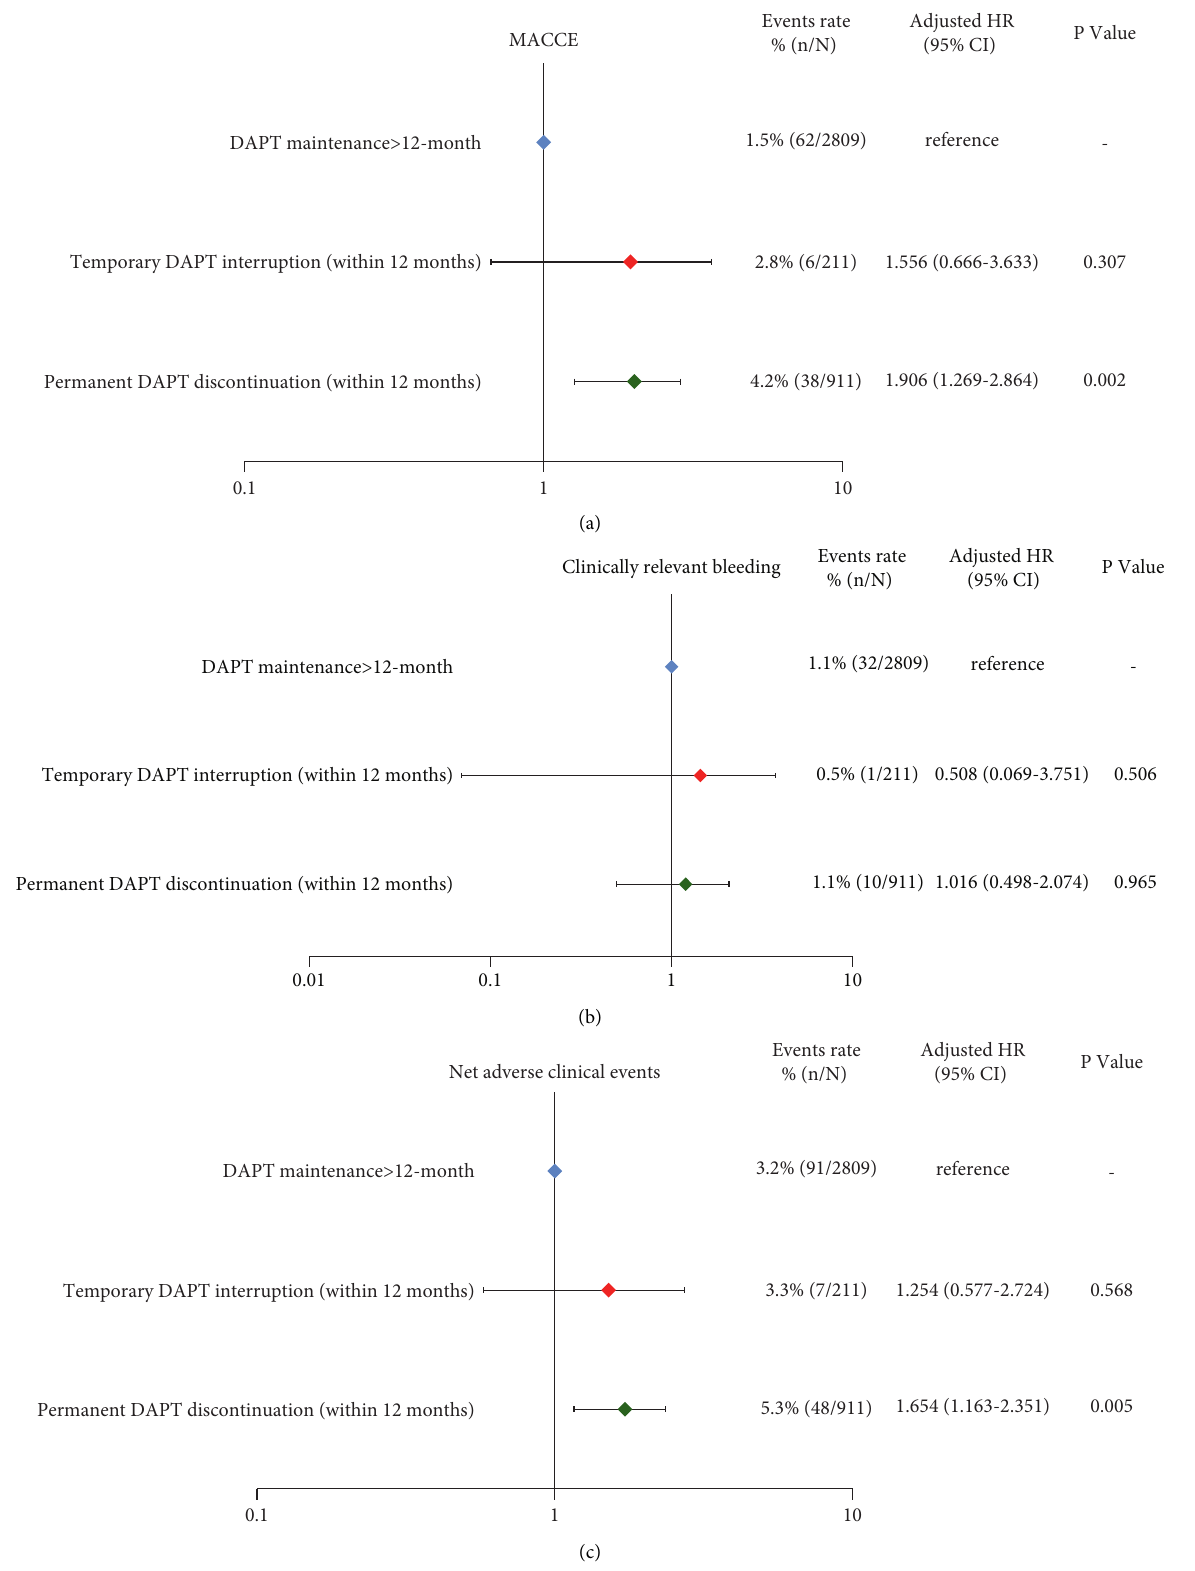
Figure 4: The differential effect of temporary or permanent DAPT interruption within the first 12months after PCI compared with DAPT maintenance > 12 months on primary ischemic and key secondary endpoints. MACCE � major adverse cardiac and cerebrovascular